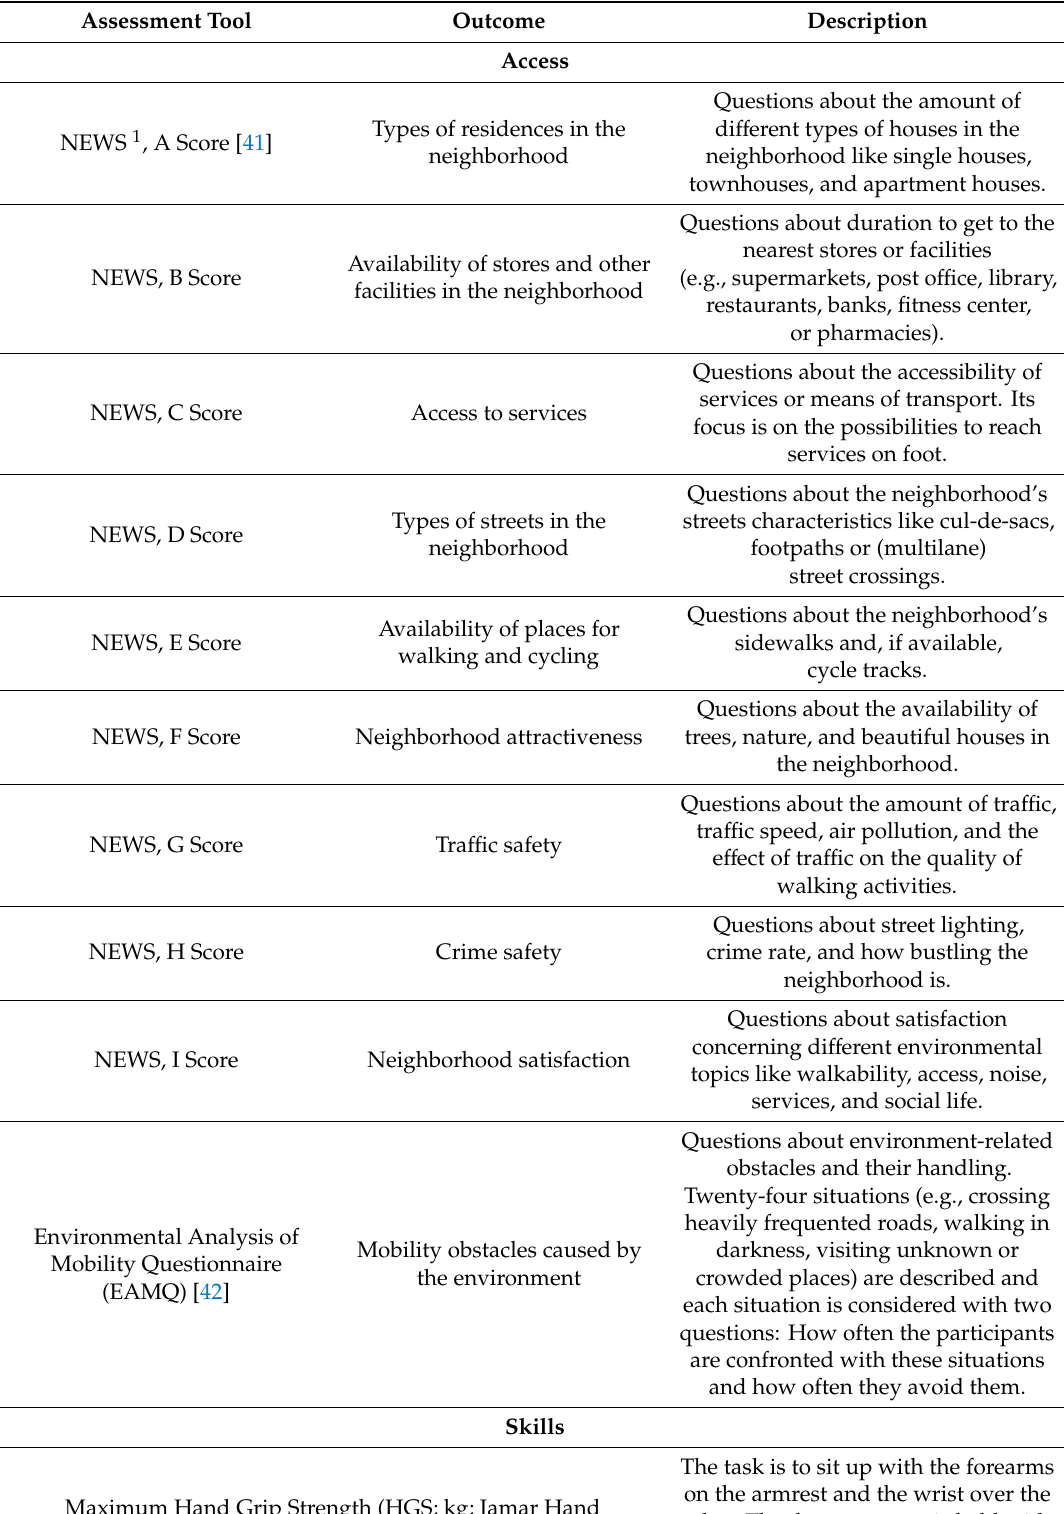
Table 1. Assessment